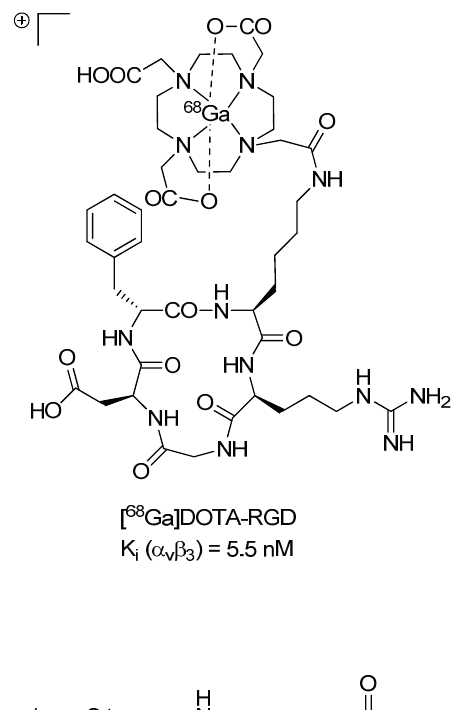
Figure 4. Chemical structures of [ 68 Ga]DOTA-RGD [10] ( top ) and [ 177 Lu]NT127 ( bottom ). Data from